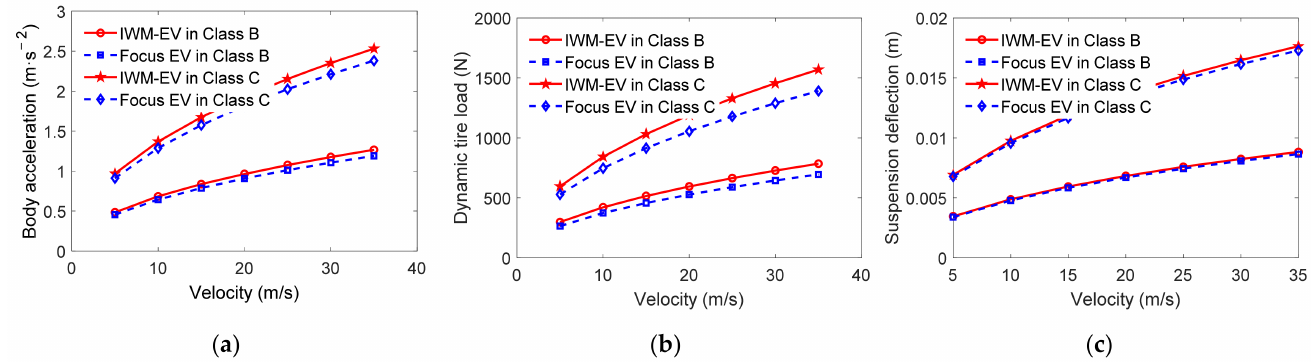
Figure 5. Dynamic characteristics: ( a ) Body acceleration; ( b ) Dynamic tire load; ( c ) Suspension